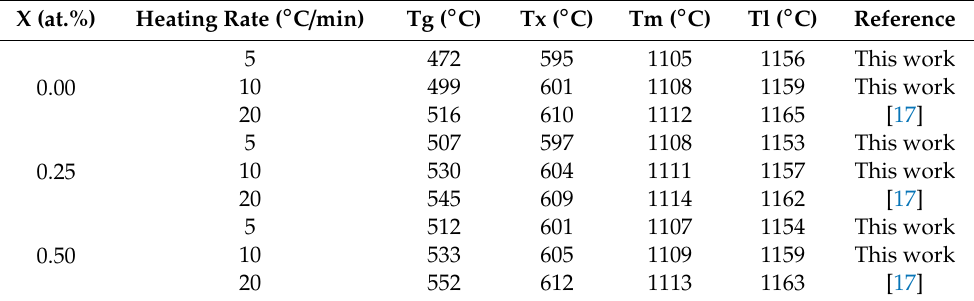
Figure 1. Differential scanning calorimetry (DSC) curves of the investigated bulk metallic glasses (BMGs) at heating rates of ( a ) 5 °C/min; ( b ) 10 °C/min; ( c ) 20 °C/min. Table 1. Effect of both copper minor addition and heating rates on the characteristics temperatures of the investigated BMGs, extracted from DSC curves.